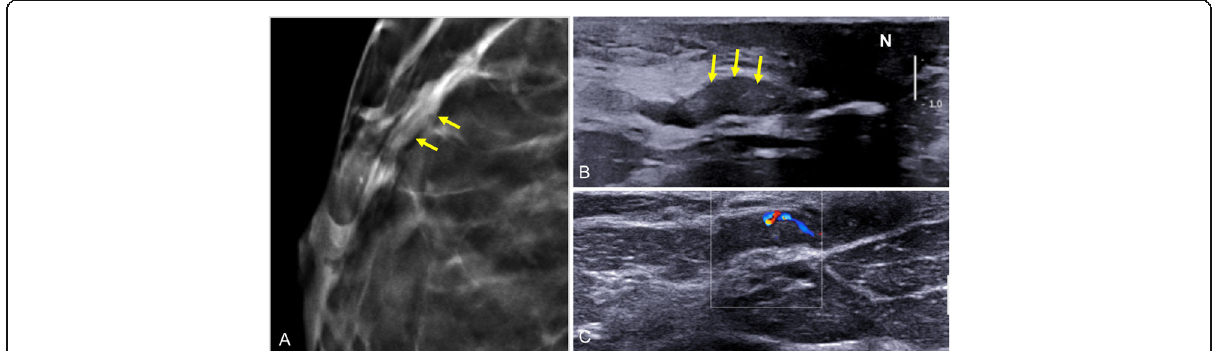
Fig. 19 Ductal ectasia with intraductal contents. Solitary intraductal papilloma. A 47-year-old woman with serous secretion from a single orifice in the right nipple. a Craniocaudal tomosynthesis slice shows a nodular image with well-defined borders in the retroareolar region of the outer quadrants with a segmental distribution (arrows). b Ultrasound shows ductal ectasia with a well-defined solid nodular lesion (arrows) adjacent to the nipple (N). c Doppler signal due to flow inside the intraductal lesion